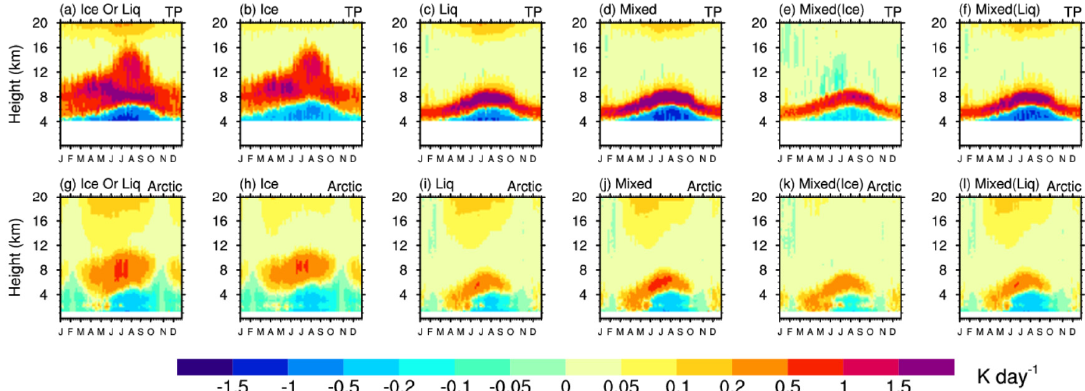
Figure 4. Rapid Radiative Transfer Model (RRTM) calculation results for the seasonal cycle of the cloud vertical SW CRE under different sky conditions per unit mass over ( a – f ) the TP and ( g – l ) the Arctic. Panels ( a ) and ( g ) show the cloud ice or liquid water contained in the atmospheric profiles; panels ( b ) and ( h ) show only the cloud ice water; panels ( c ) and ( i ) show only cloud water; panels ( d ) and ( j ) show only the mixed-phase cloud water layer; panels ( e ) and ( k ) show only the ice water portion in the mixed-phase clouds; panels ( f ) and ( l ) show only the liquid water portion in the mixed-phase clouds. Positive and negative values represent the heating and cooling rates, respectively. Unit: K day − 1 .